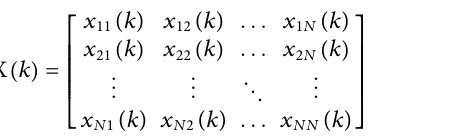
Frontiers in Physics |